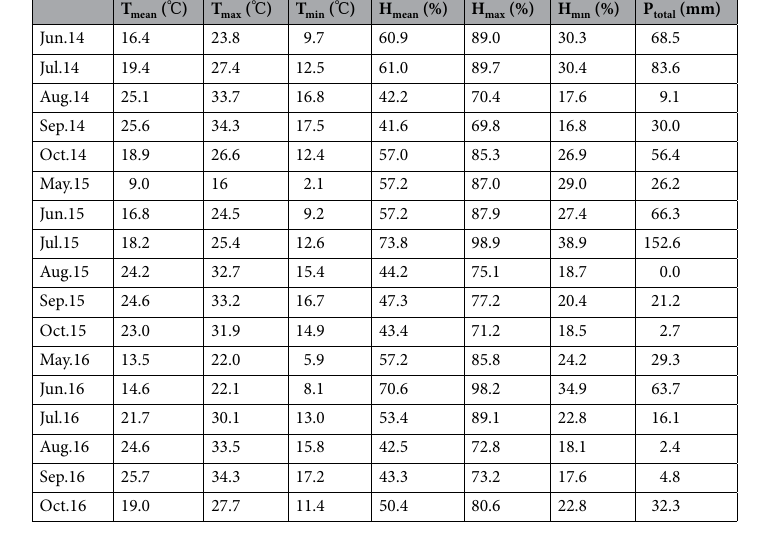
Table 1. Climatic variables for Yeşilöz recorded monthly by the Turkish State Meteorological Service (average values of the month 15 days prior to the collection date).